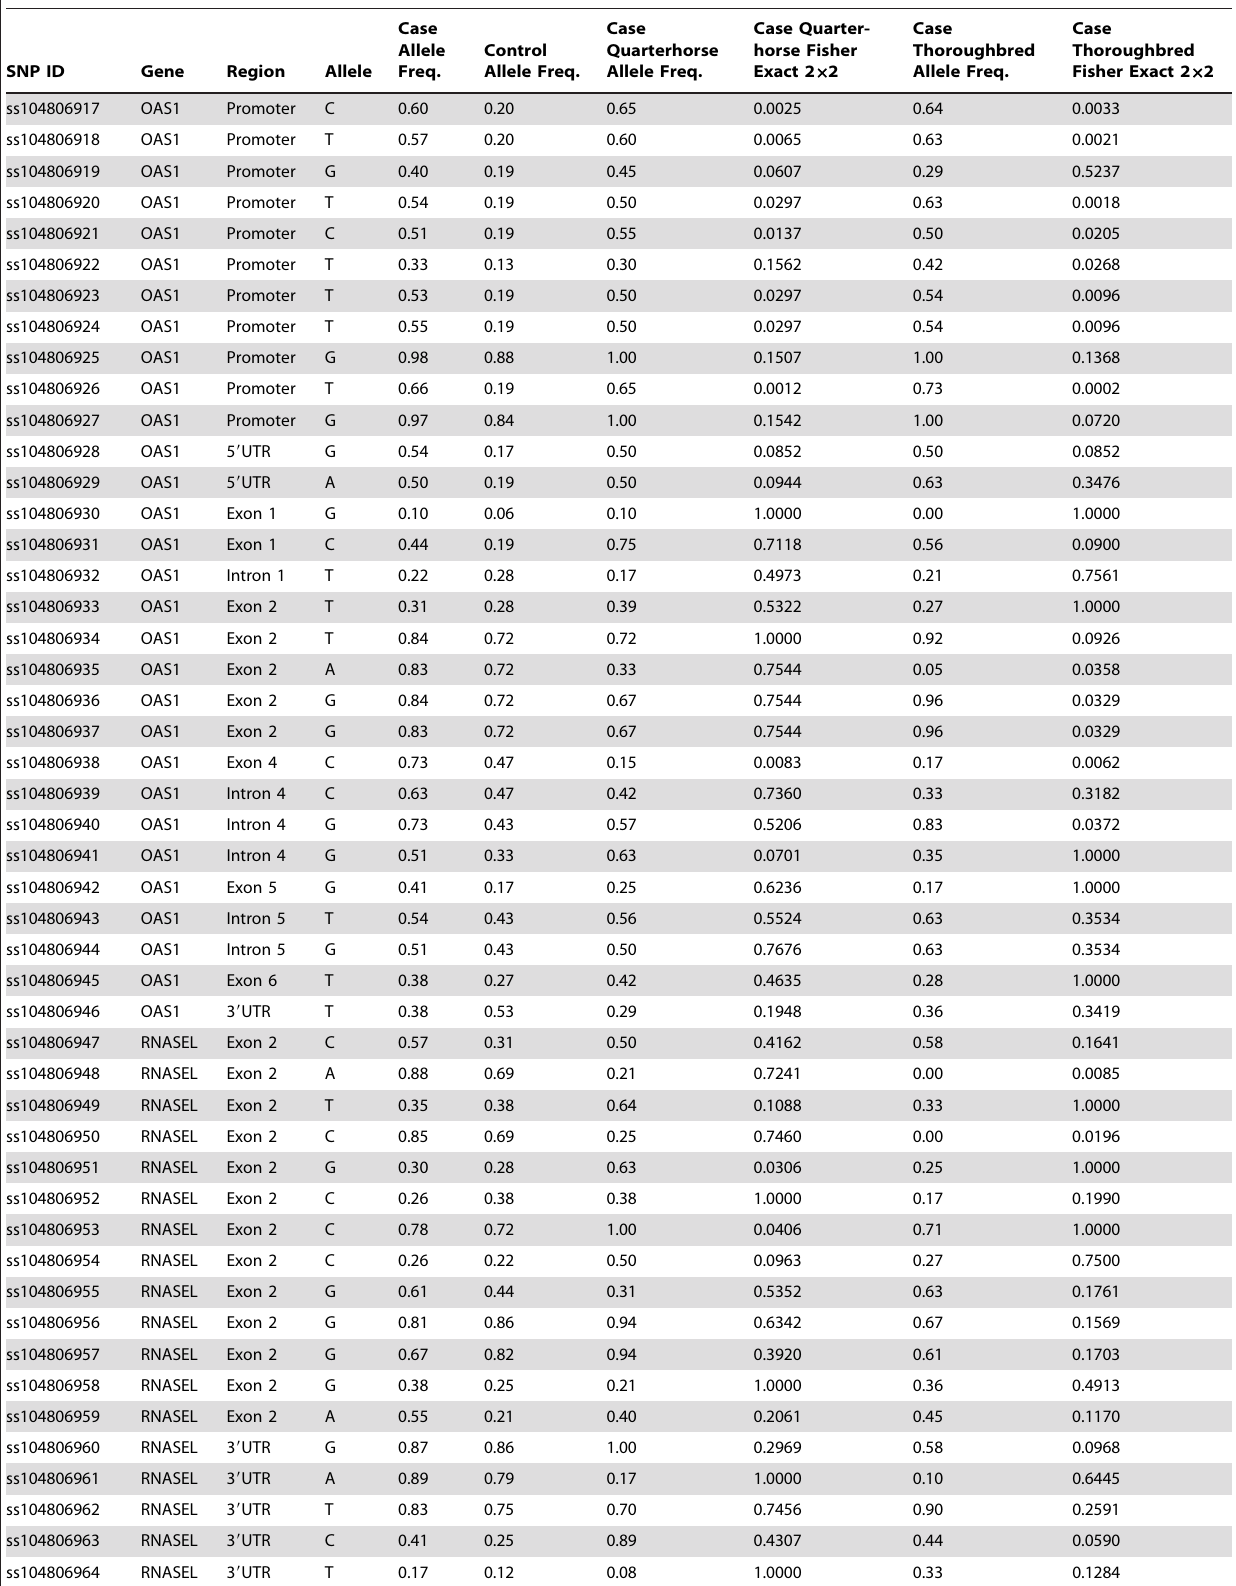
Table 3. Quarterhorse and Thoroughbred breed case-control allelic Fisher’s Exact analysis.